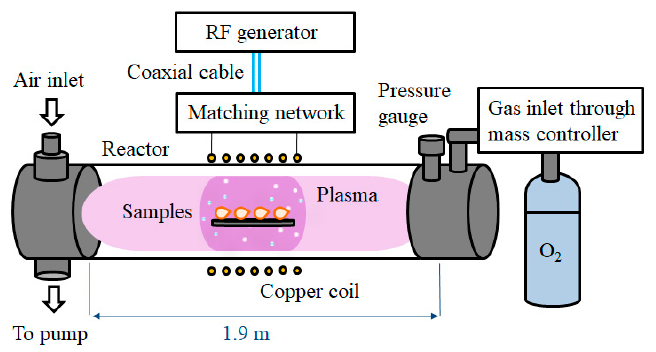
Figure 1. Schematic representation of the plasma system used in the treatment of garlic cloves.